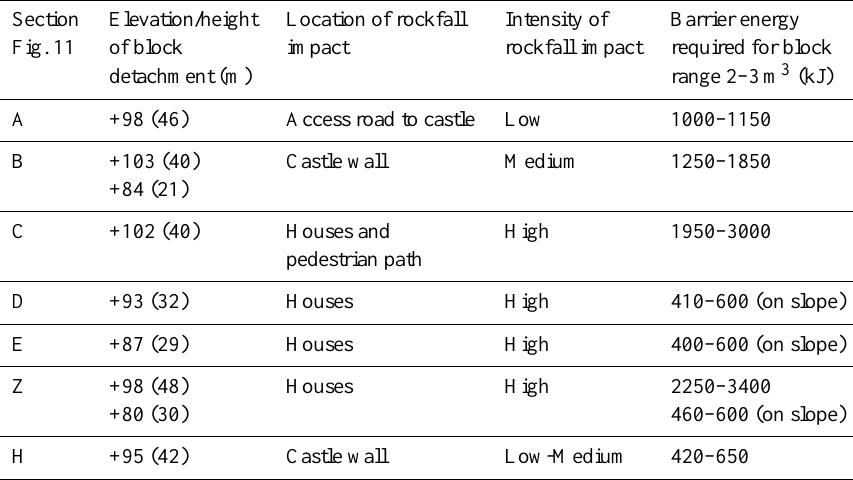
Table 2. Rockfall analysis results in different slope